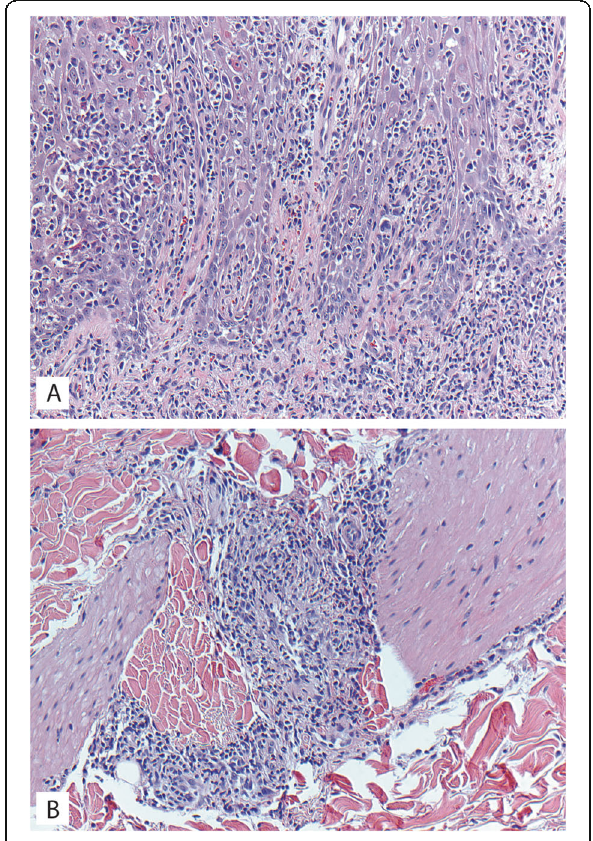
Fig. 2 Microscopic images of Case 1 histopathology. a Biopsy of left thigh lesion showing dense lichenoid and epidermotropic infiltrate of small to medium size lymphocytes with irregular nuclear contours; H&E 200X. b Biopsy of left thigh lesion showing a nodular granulomatous and lymphocytic dermal infiltrate centered on a vessel; H&E